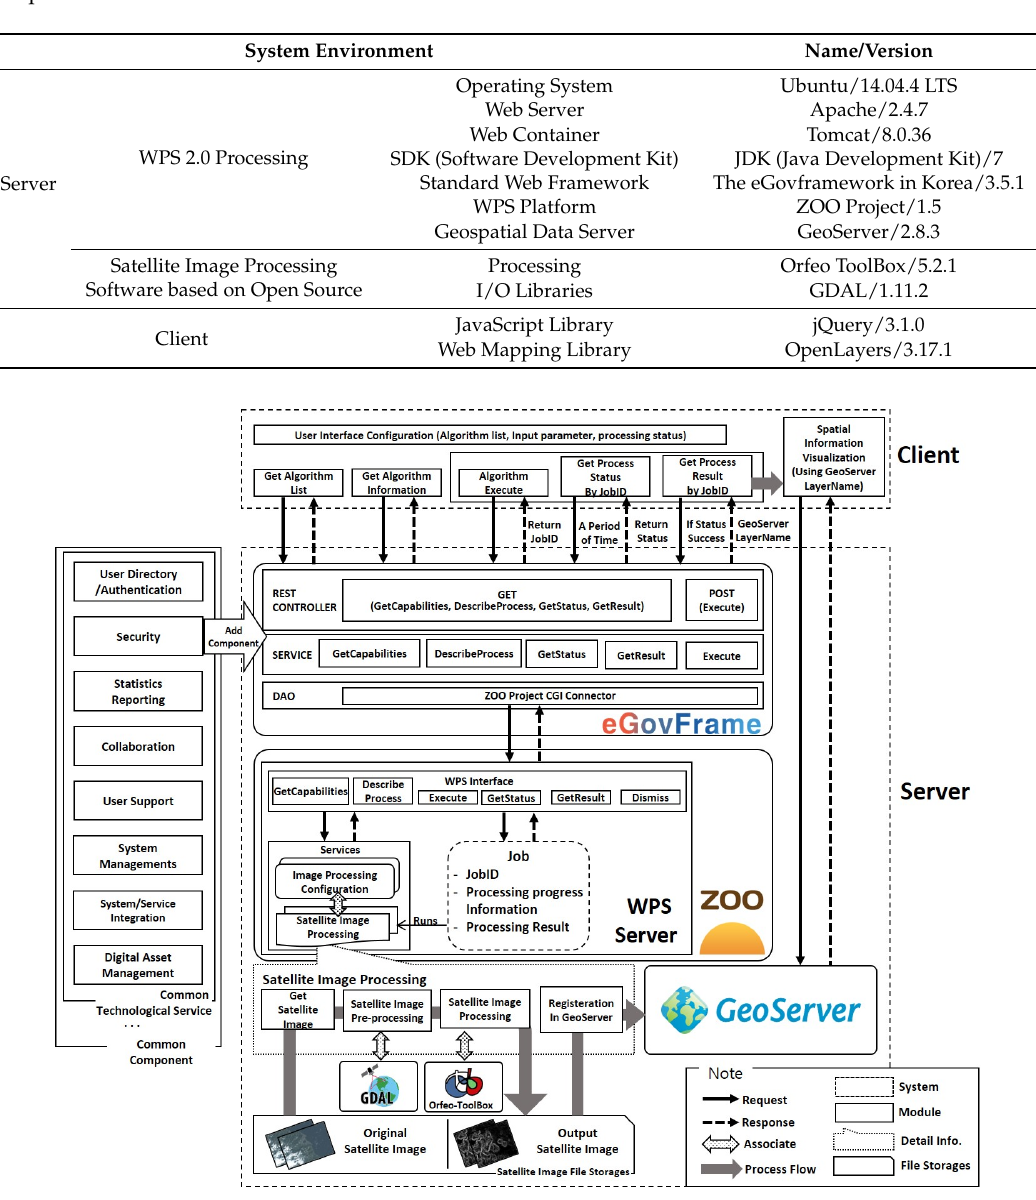
Figure 1. System design based on the eGovframework using open sources for geoprocessing and manipulation of geo-based images, including the ZOO-project.